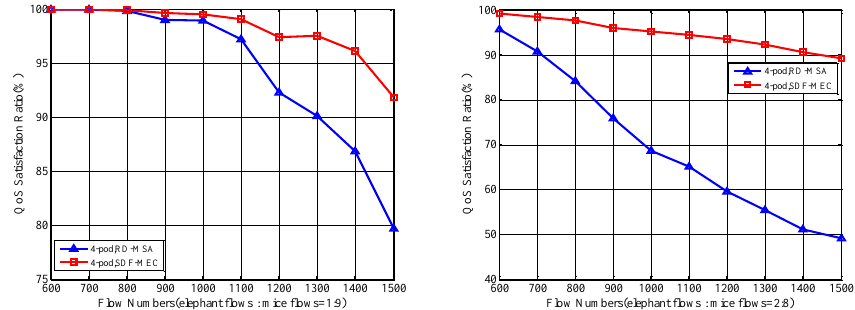
Figure 6. QoS satisfaction ratio of Random-order Demand minimum switch activation (RD-MSA) and SDF-MEC in 4-pod